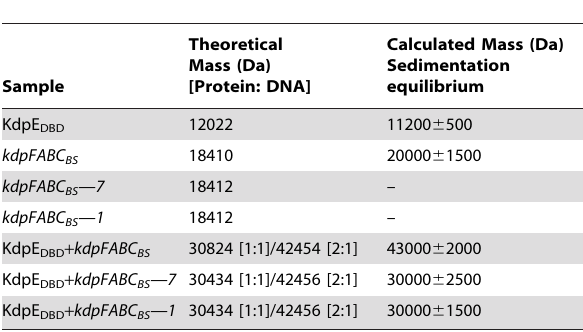
Table 2. Comparison of molecular masses calculated from sequence and sedimentation equilibrium analysis of KdpE DBD , its DNA recognition sequence, and their